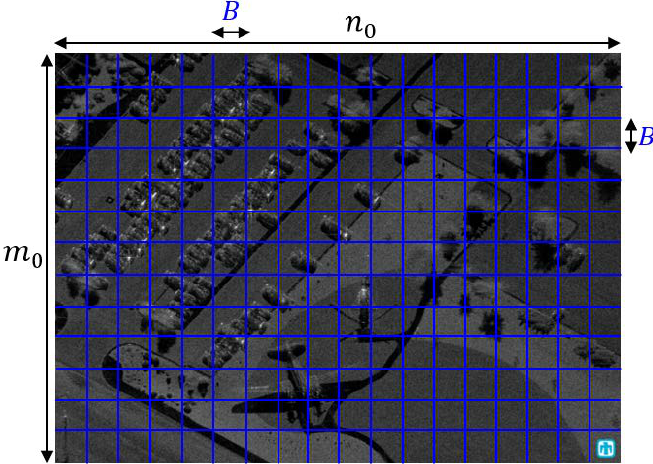
Figure 1. Image partitioning into multiple blocks (original SAR image from